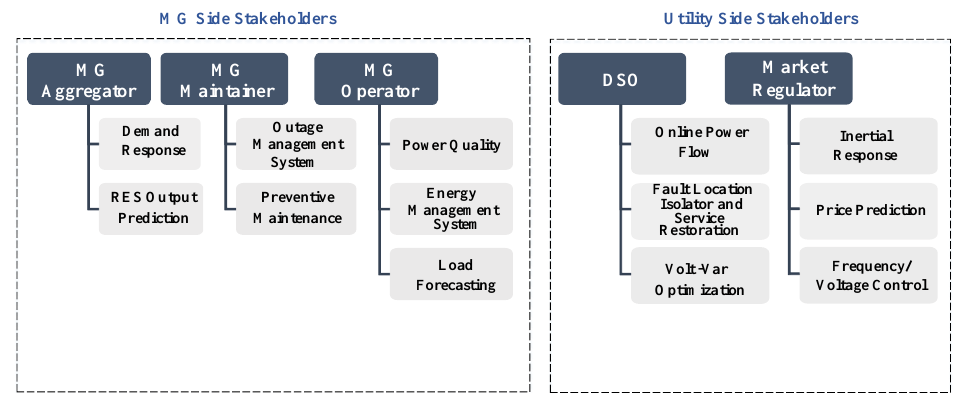
Figure 3. MG application requirements based on